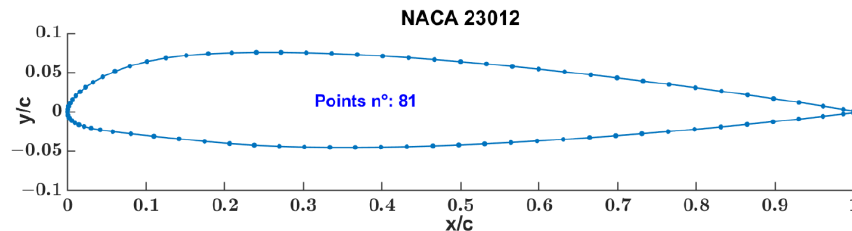
Figure 20. NACA 23012 input airfoil.